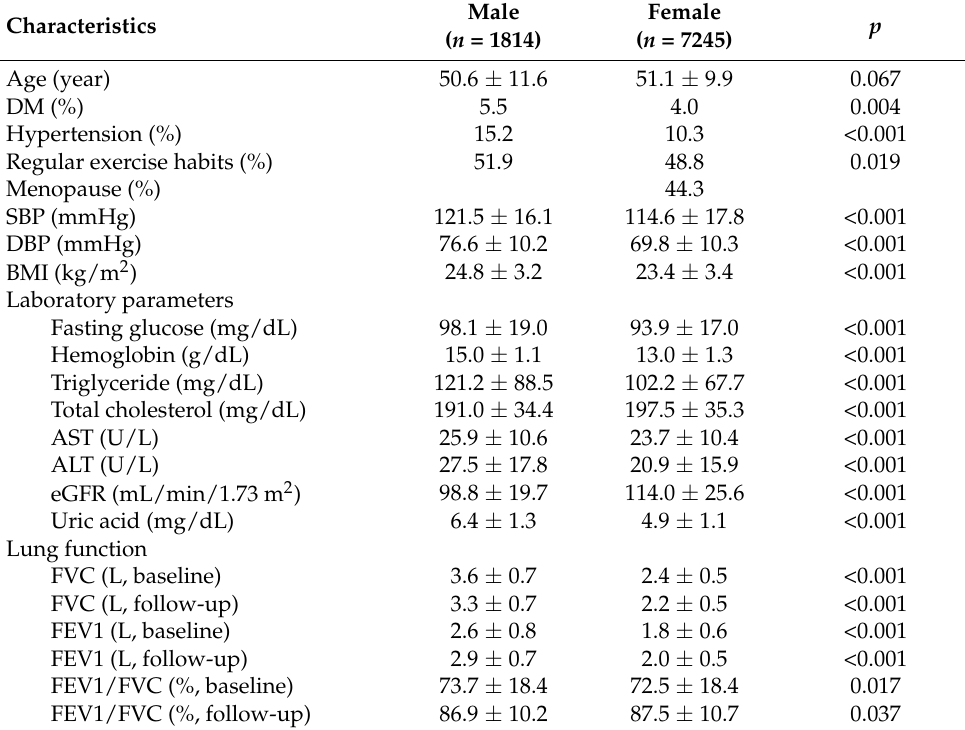
Table 1. Comparison of clinical characteristics among participants according to different gender.